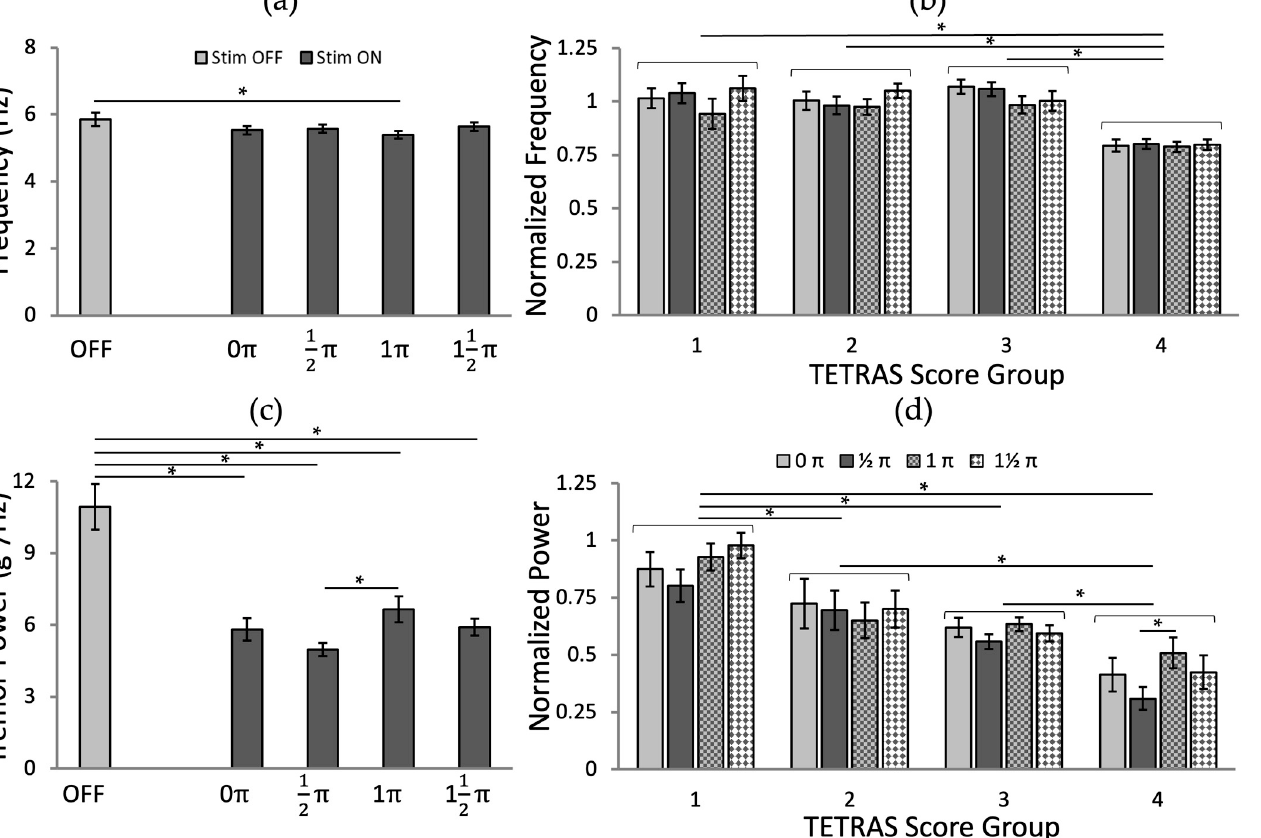
Figure 9. The effects of the phase-locked stimulation at four different phases by tremor metrics: ( a ) Tremor frequency and ( c ) power. The normalized tremor metrics for the different phases of stimulation by the TETRAS Score groups: ( b ) Tremor frequency and ( d ) power. The error bars represent the standard errors. *: p < 0.05.